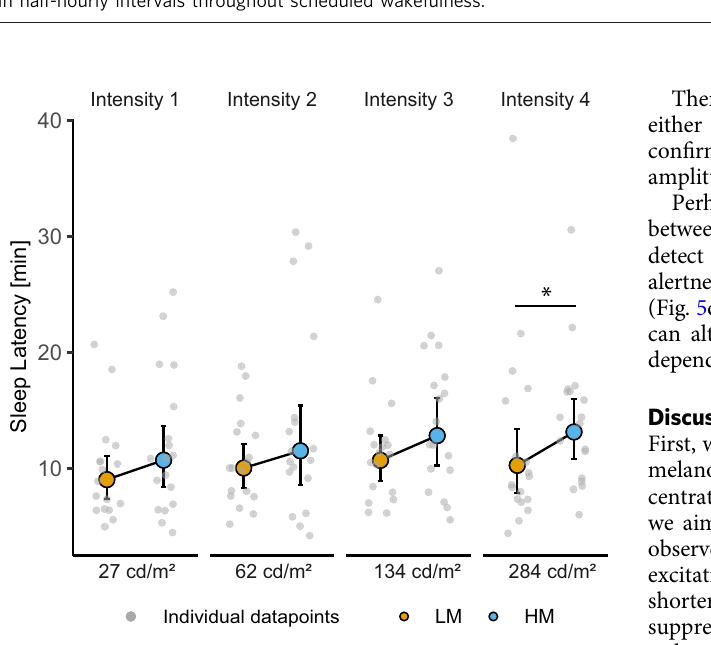
Fig. 1 Lighting conditions and experimental protocol of the study. a Participants were assigned to one of the four light intensity groups ( n = 18 per group) that differed in luminance [cd/m 2 ]. b Irradiance of all four light intensity groups [W/(sqm*nm)]. Irradiances of the low melanopic condition (LM) are depicted with orange lines and the high melanopic condition (HM) with blue lines. c Summation of the alpha-opic equivalent daylight illuminance for the three cone types (CIE S 0 26) [lx] in the four intensity groups (S-cones: blue bars; M-cones: green bars; L-cones: red bars). d Melanopic equivalent daylight illuminance (mEDI) in the four intensity groups shows the ~200 – 300% melanopsin contrast (Contrast = (HM-LM)/LM [%]; Ratio = HM/LM) between the low melanopic (LM: orange bars) and high melanopic (HM: blue bars) condition. e Photo illustrating screen and experimental setup. Participants were sitting at a distance of 60 cm in front of the screen. f The study protocol consisted of one adaptation night and two 17-h blocks either under the LM or HM condition. The order of both conditions was balanced. Both experimental blocks started 7 h prior to habitual bedtime under standard fl uorescent light (~67 lx). Before light exposure, there were two episodes of dark adaptation (~0.1 lx) and one dim light episode (~0 – 7 lx) for adaptation of photoreceptor sensitivity and to collect baseline measurements. Participants were exposed to LM or HM, respectively, for 3.5 h, starting 4 h before habitual bedtime. The light exposure was followed by an 8-h sleep episode, which was polysomnographically recorded (for details, see “ Methods ” section) and a 1-h dim light episode the next morning. The yellow triangles indicate the timing of the cognitive test batteries. The results of the cognitive tasks will be published elsewhere. Before, during, and in the morning after light exposure, salivary melatonin levels were measured, and subjective levels of sleepiness were rated in half-hourly intervals throughout scheduled wakefulness.